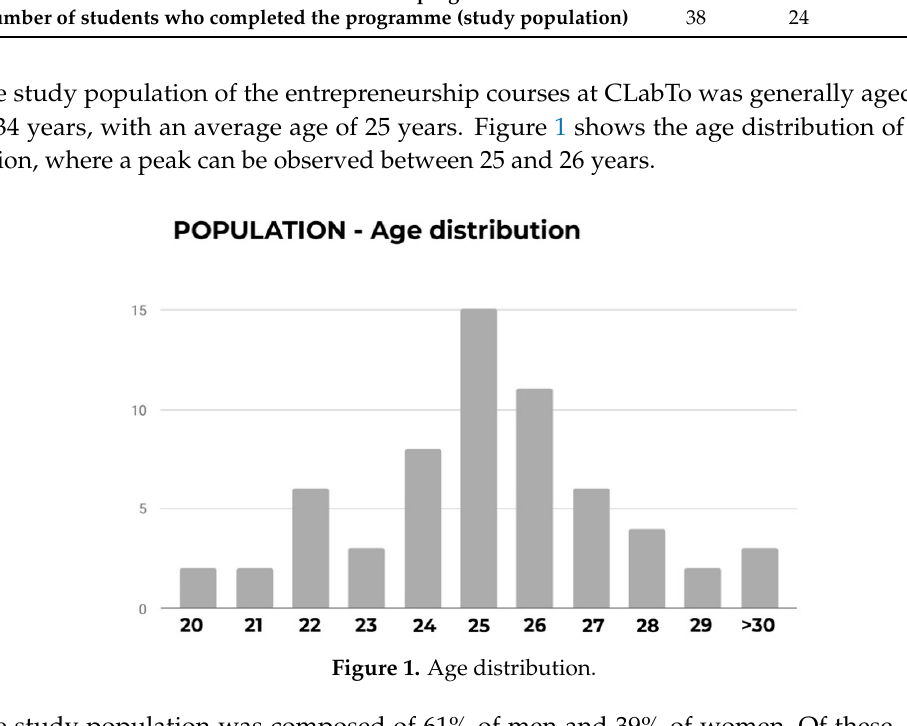
Table 3. Students who completed the programme divided according to their fields of study.